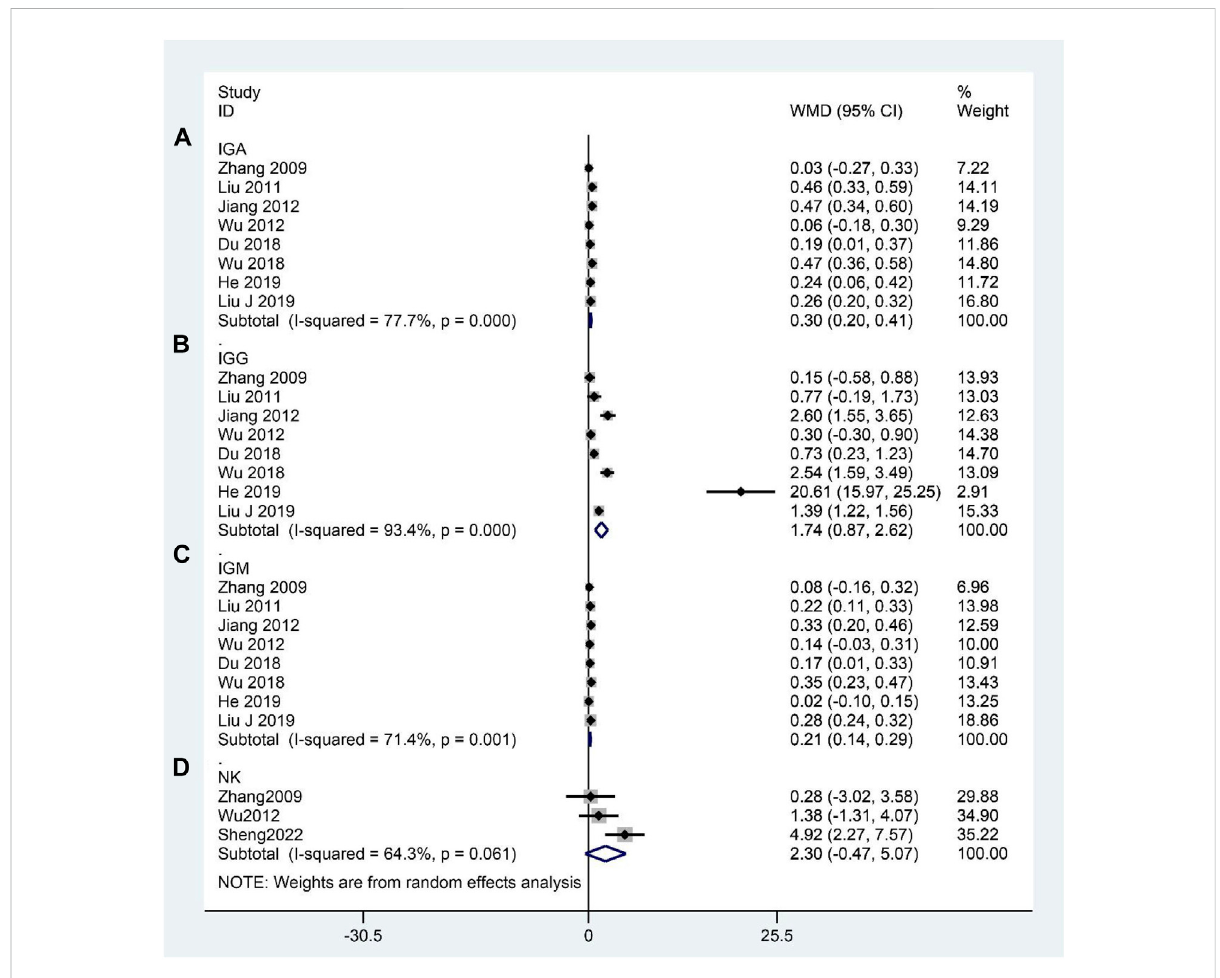
FIGURE 8 Forest plot for immunological indicators: (A) IGA, (B) IGG, (C) IGM, and (D) NK